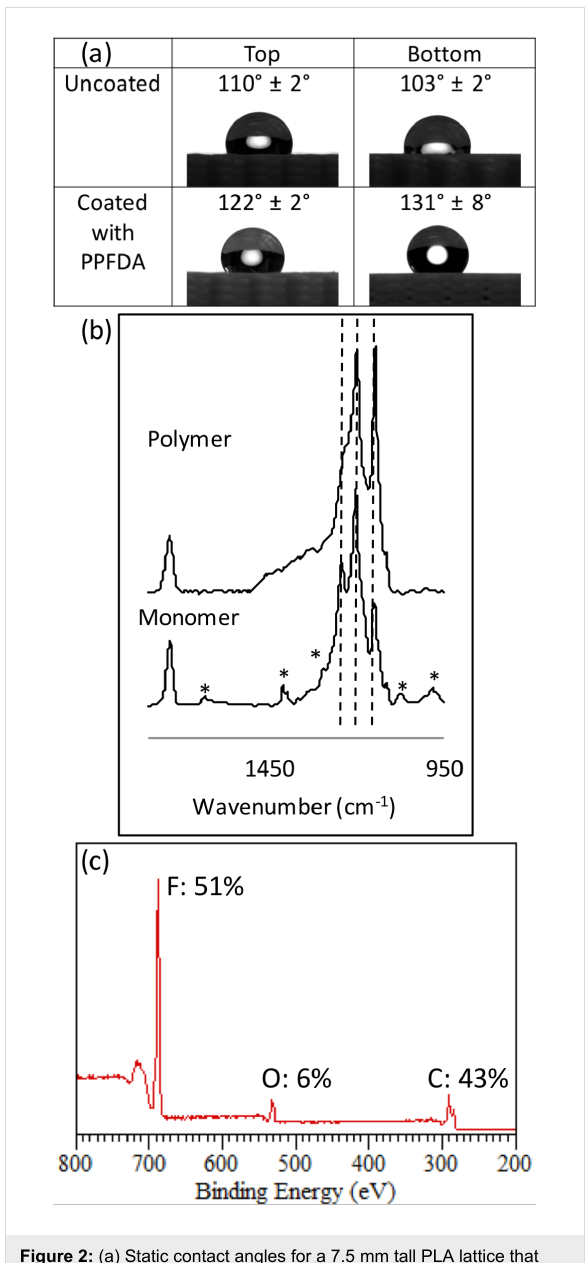
Figure 2: (a) Static contact angles for a 7.5 mm tall PLA lattice that was uncoated and coated with PPFDA. (b) FTIR spectra of the PPFDA film (top) and liquid monomer (bottom). Dashed lines correspond to the CF 2 and CF 3 signals, and the asterisks in the monomer spectrum cor- respond to the vinyl signals. (c) Representative XPS survey spectrum of the top of the lattice coated with